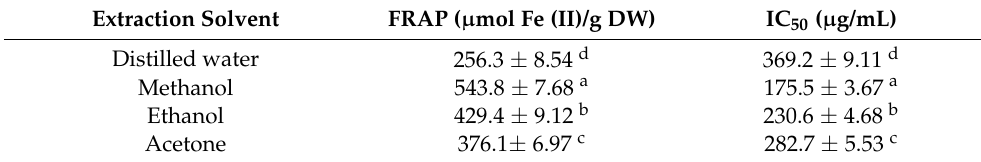
Table 4. FRAP assay activity and IC 50 values of different extracts from Caralluma edulis plant. Extraction